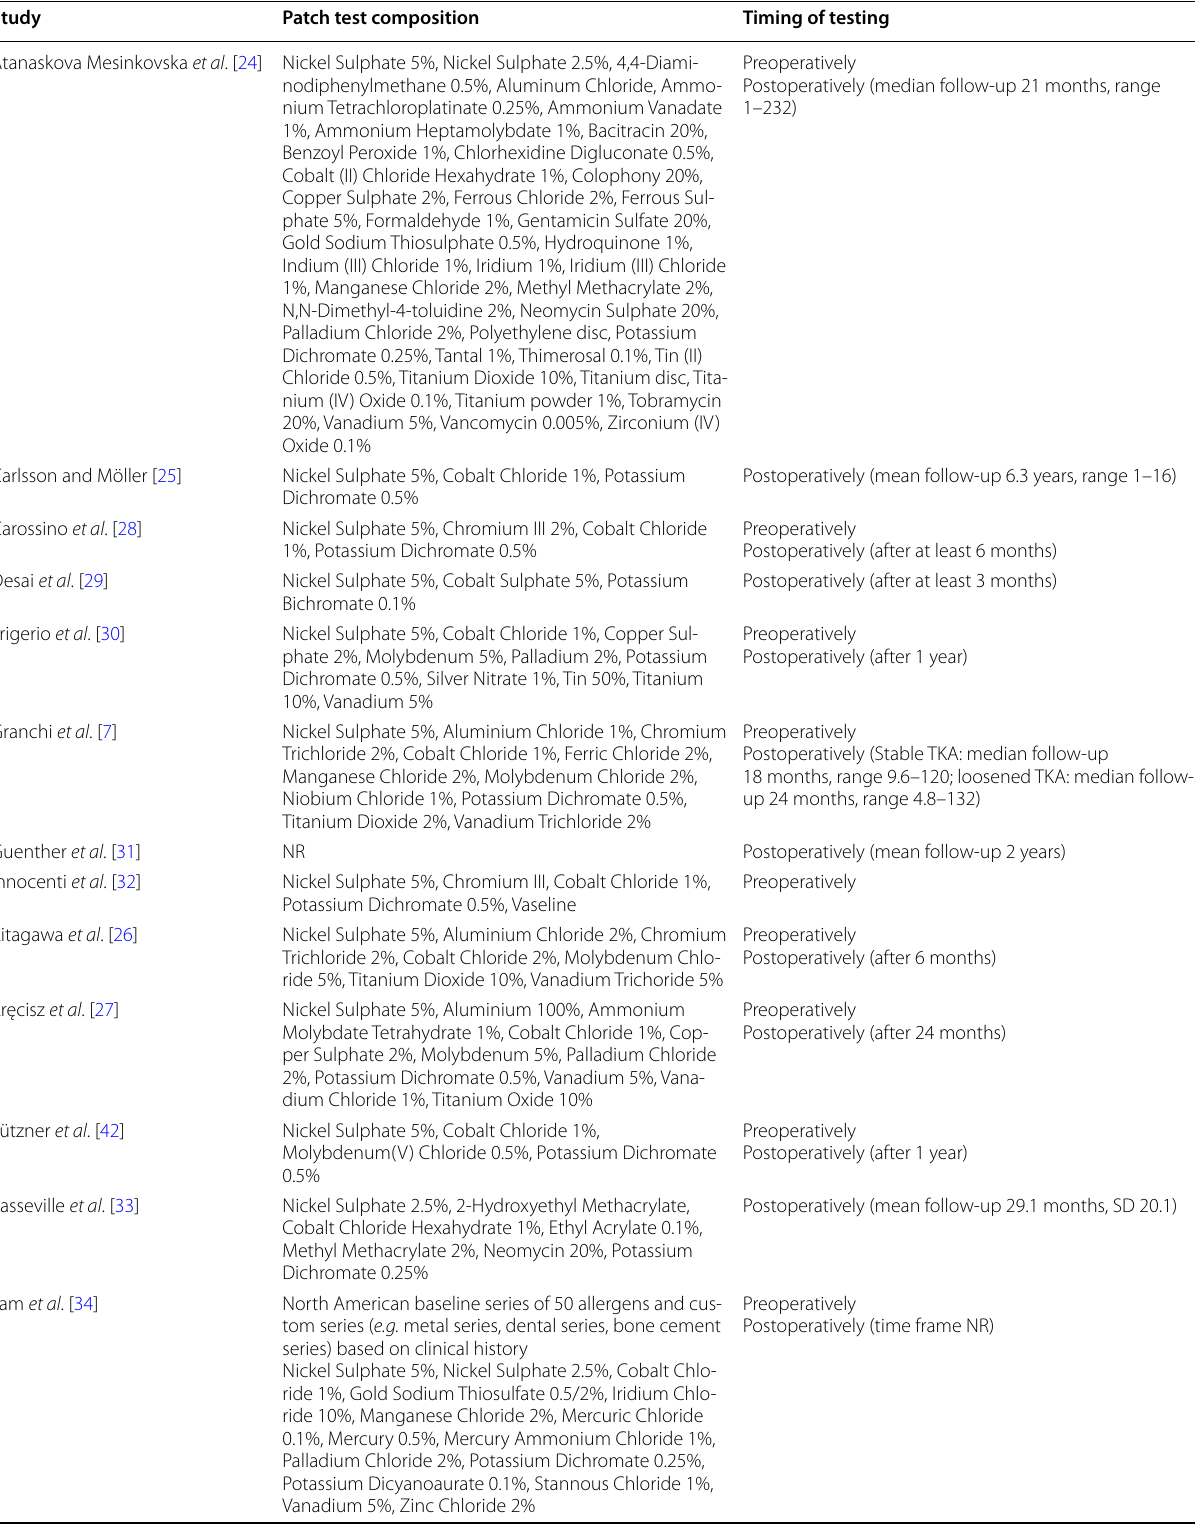
Table 4 Patch test composition and timing of testing for each study Study Patch test composition Timing of